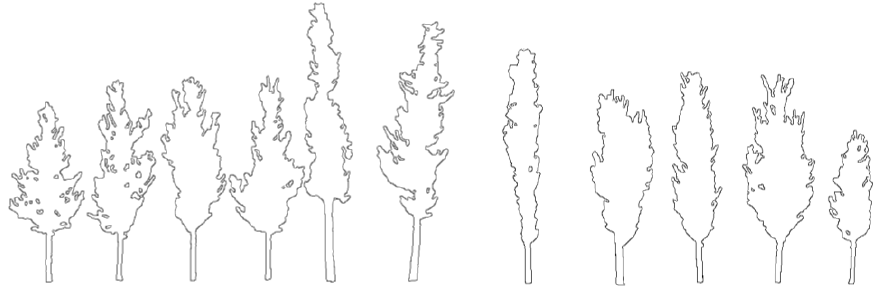
Figure 7. Tree edges extracted by Canny algorithm.